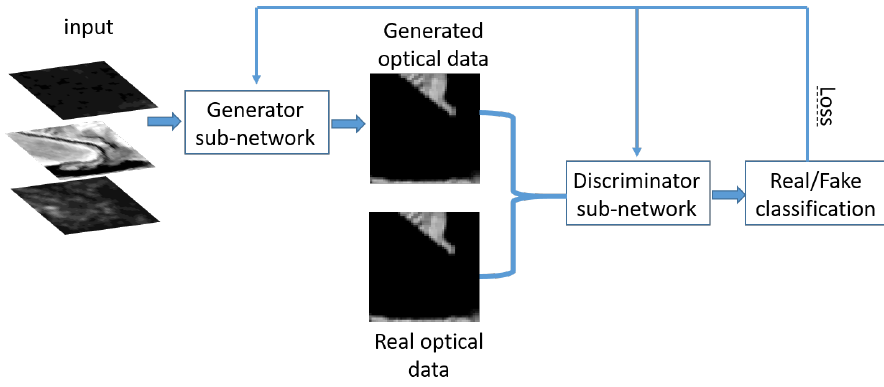
Figure 3. The flowchart of the cGAN architecture.